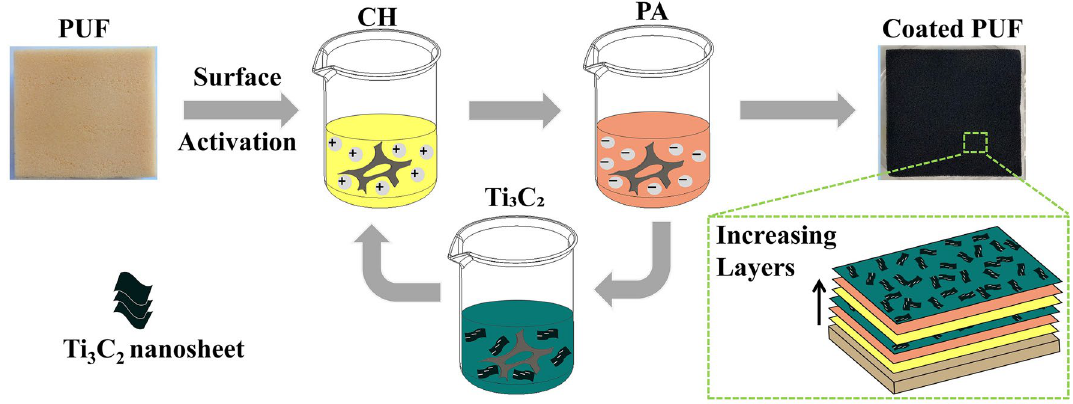
Figure 1. Schematic diagram of the fabrication process of CH/PA/Ti 3 C 2 coated PUF via LbL